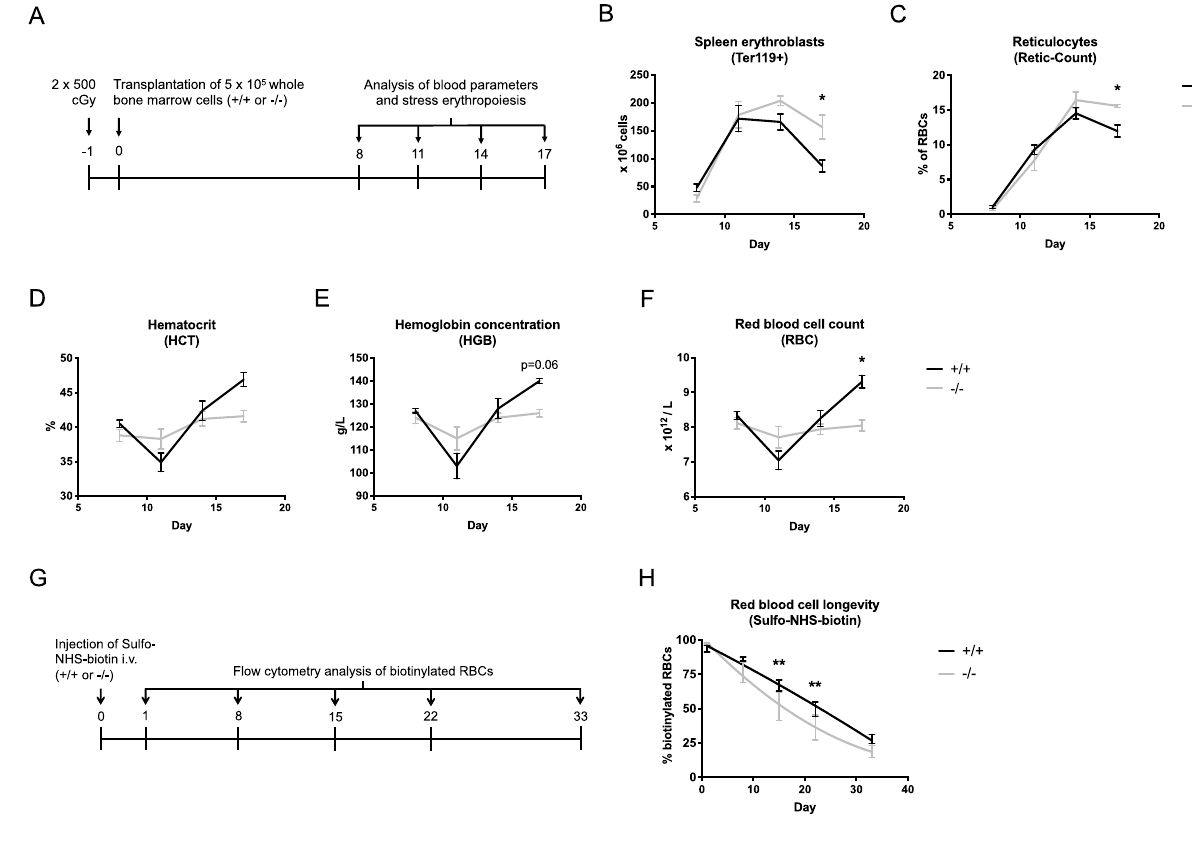
Figure 3. Ypel4 -null hematopoietic cells display reduced anemia-recovering capacity due to an increased clearance of circulating erythrocytes. ( A ) Stress erythropoiesis was induced using lethal irradiation followed by transplantation of unfractionated wild-type (+/+) or Ypel4 -null (−/−) bone marrow (BM) cells to +/+ recipients, followed by analysis of anemia recovery in spleen and peripheral blood (PB) at day 8, 11, 14 and 17. ( B ) Expansion of the Ter119+ erythroid fraction in spleen as quantified by cell counting and flow cytometry (n = 3). ( C ) Percentage of reticulocytes of total red blood cells as quantified by flow cytometry (n = 3). PB analysis of ( D ) hematocrit (HCT) (n = 3), ( E ) hemoglobin concentration (HGB) (n = 3) and ( F ) red blood cell (RBC) count (n = 3) by utilization of a hematology analyzer. ( G ) RBC longevity was analyzed by i.v. injection of Sulfo-NHS- biotin followed by flow cytometric quantification of biotinylated RBCs in PB at day 1, 8, 15, 22 and 33. ( H ) Percentage of biotinylated RBCs in PB over time with estimated clearance rates of wild-type (+/+) and Ypel4 - null (−/−) RBCs (n = 5). Data displayed as average ± SEM, *P ≤ 0.05, **P ≤ 0.01, i.v.